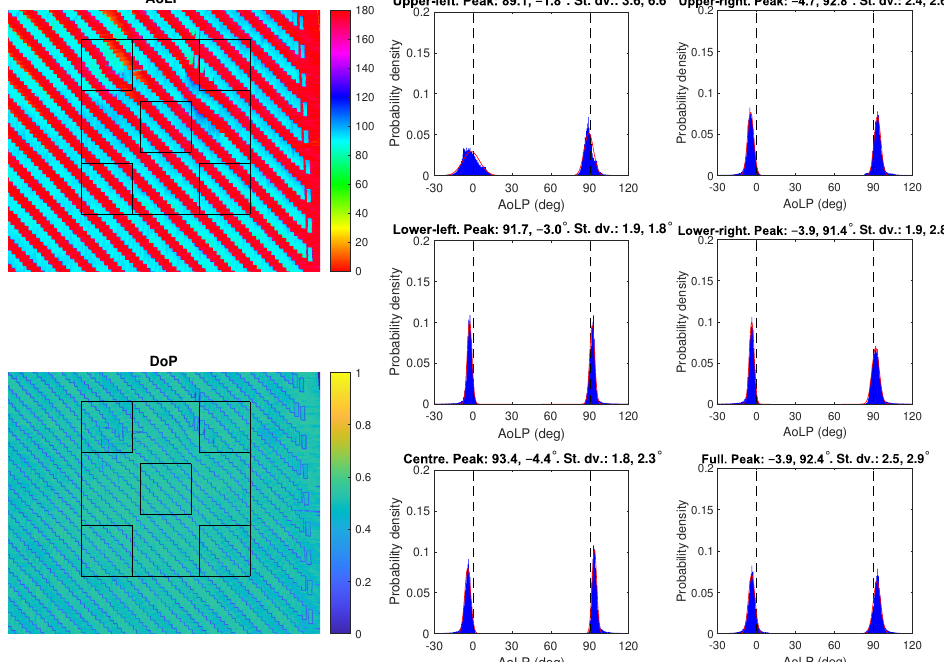
Figure 16. Results for a dry woven sample taken in similar conditions to the case of Figure 9.